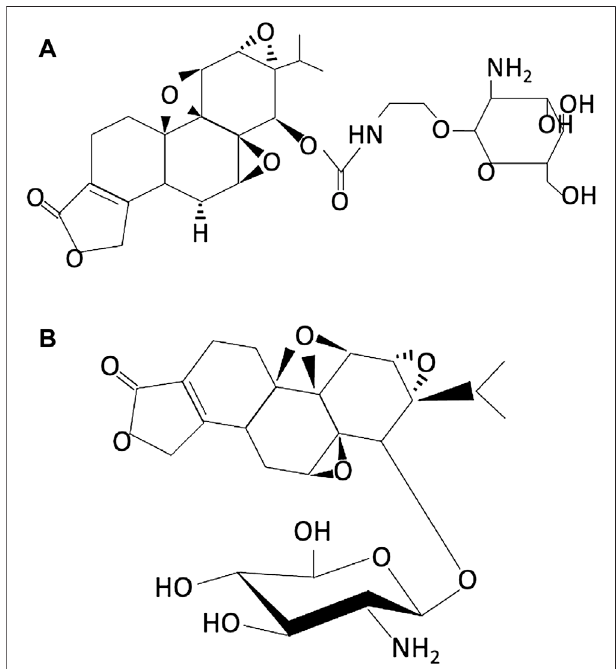
FIGURE 3 | Chemical structure of (A) TPG12 (reproduced from Ref 53) and (B) TPAG16 (reproduced from Ref